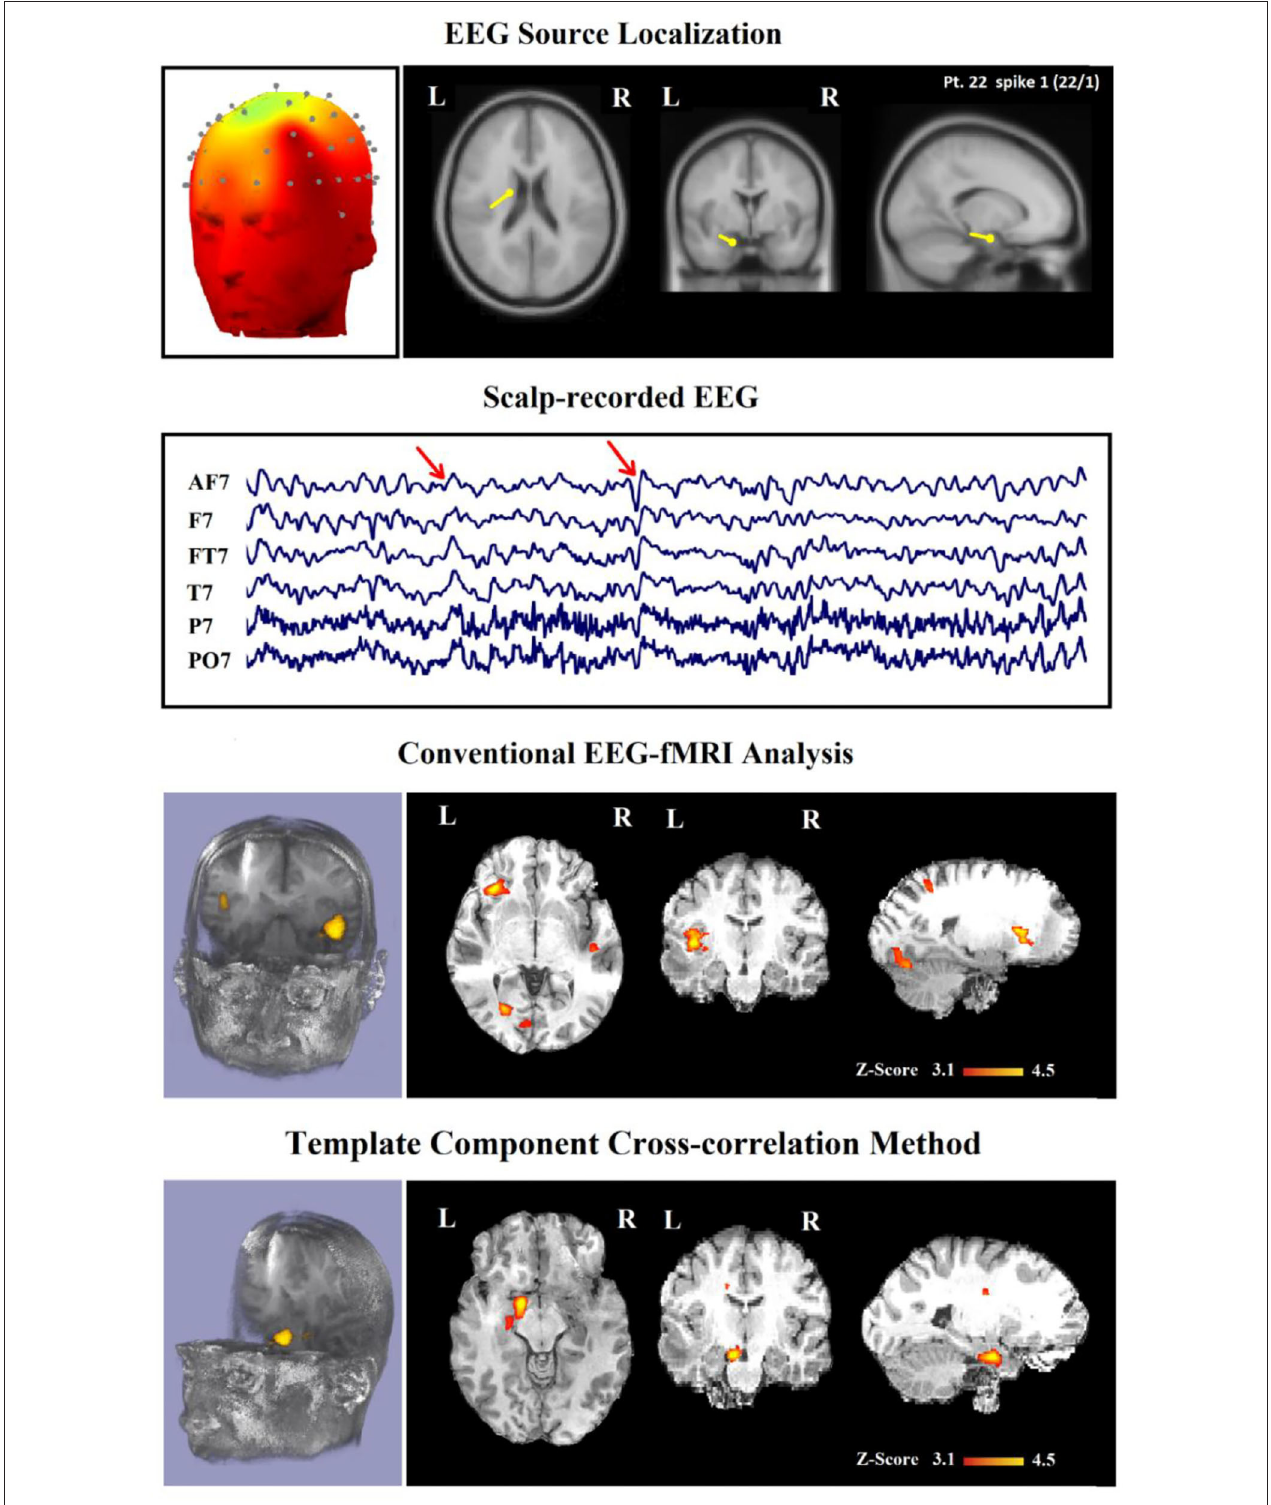
FIGURE 9 | (Patient 22—spike 1) marked events are AF7, T7, and FT7 spikes (referential montage) and the TCCC-related BOLD response demonstrates a neocortical activation in the caudate nucleus and lentiform nucleus for the TCCC method, this response is considered both concordant with the spike field